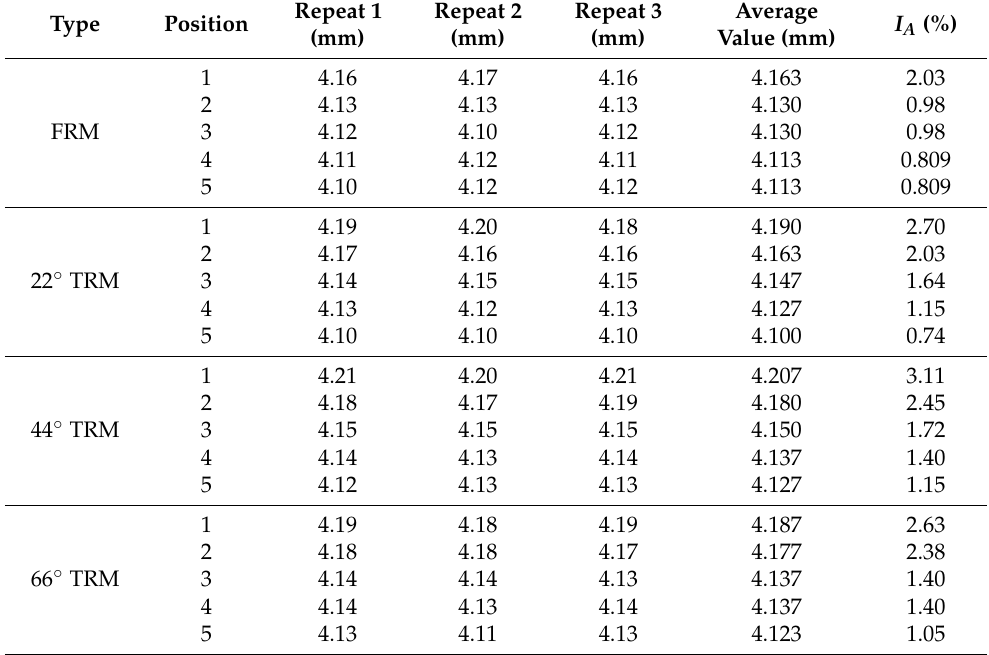
Table 5. The measured results of relative interference for different rivet